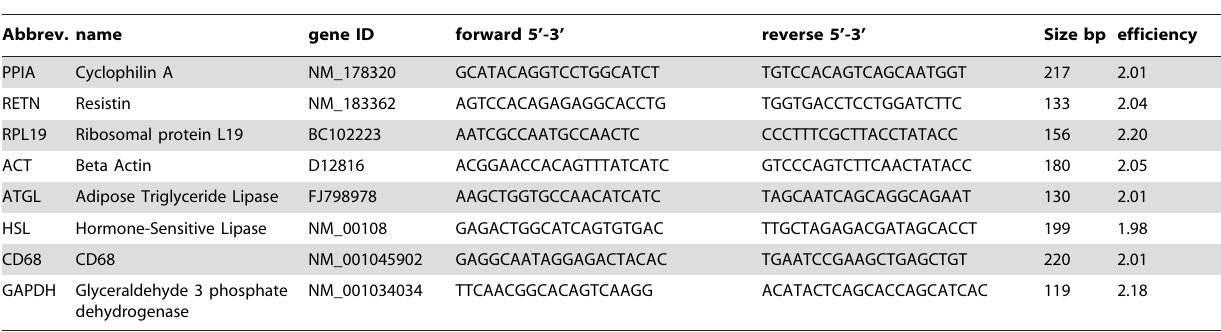
Table 1. Oligonucleotide primers